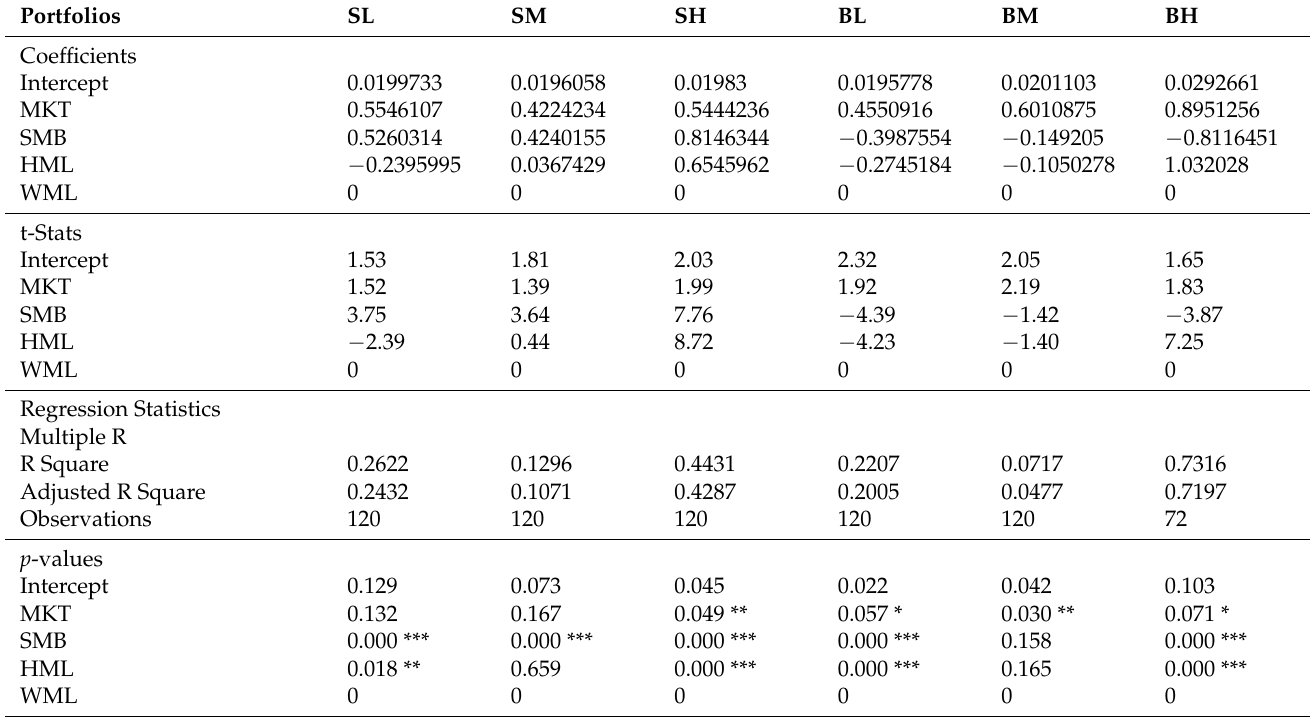
Table 5. The FF3F Model Regression